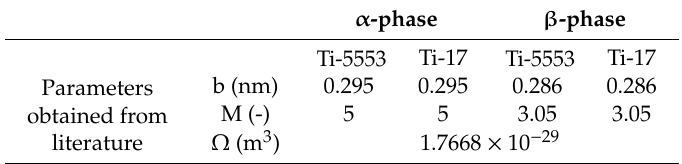
Table A2. Parameters obtained from the literature and used in the developed model.